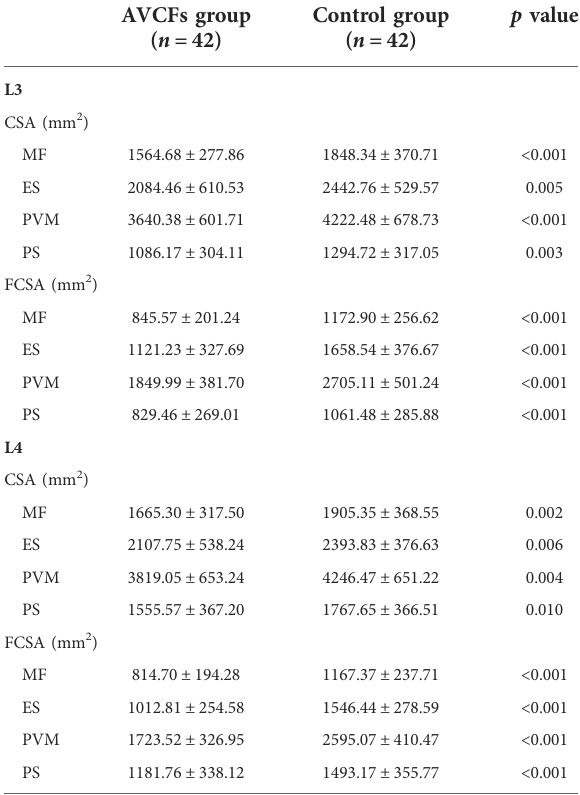
CSA indicates cross-sectional area; FCSA, functional cross-sectional area; MF, multi fi dus; ES, erector spinae; PVM, paravertebral muscle; PS,